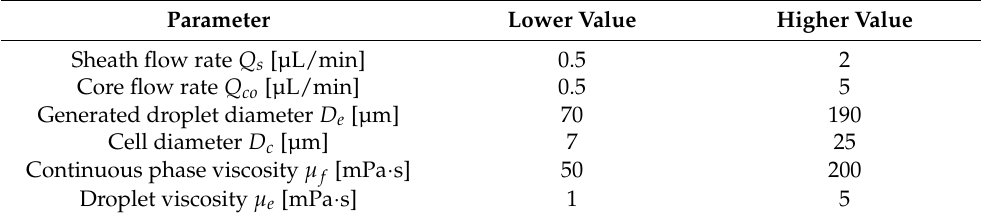
Table 1. Parameters with a potential effect on the rotational flow field and the average cell velocity v c . Parameter Lower Value Higher Value Sheath flow rate Q s